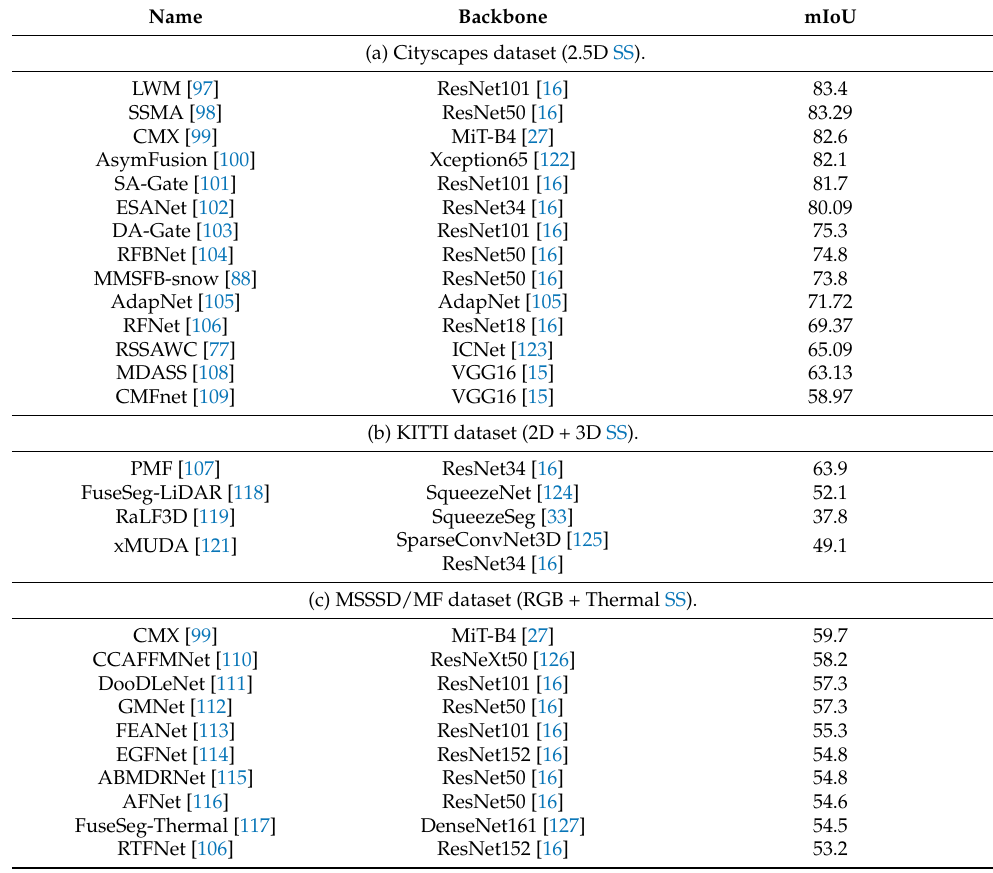
Table 4. Architectures Performance